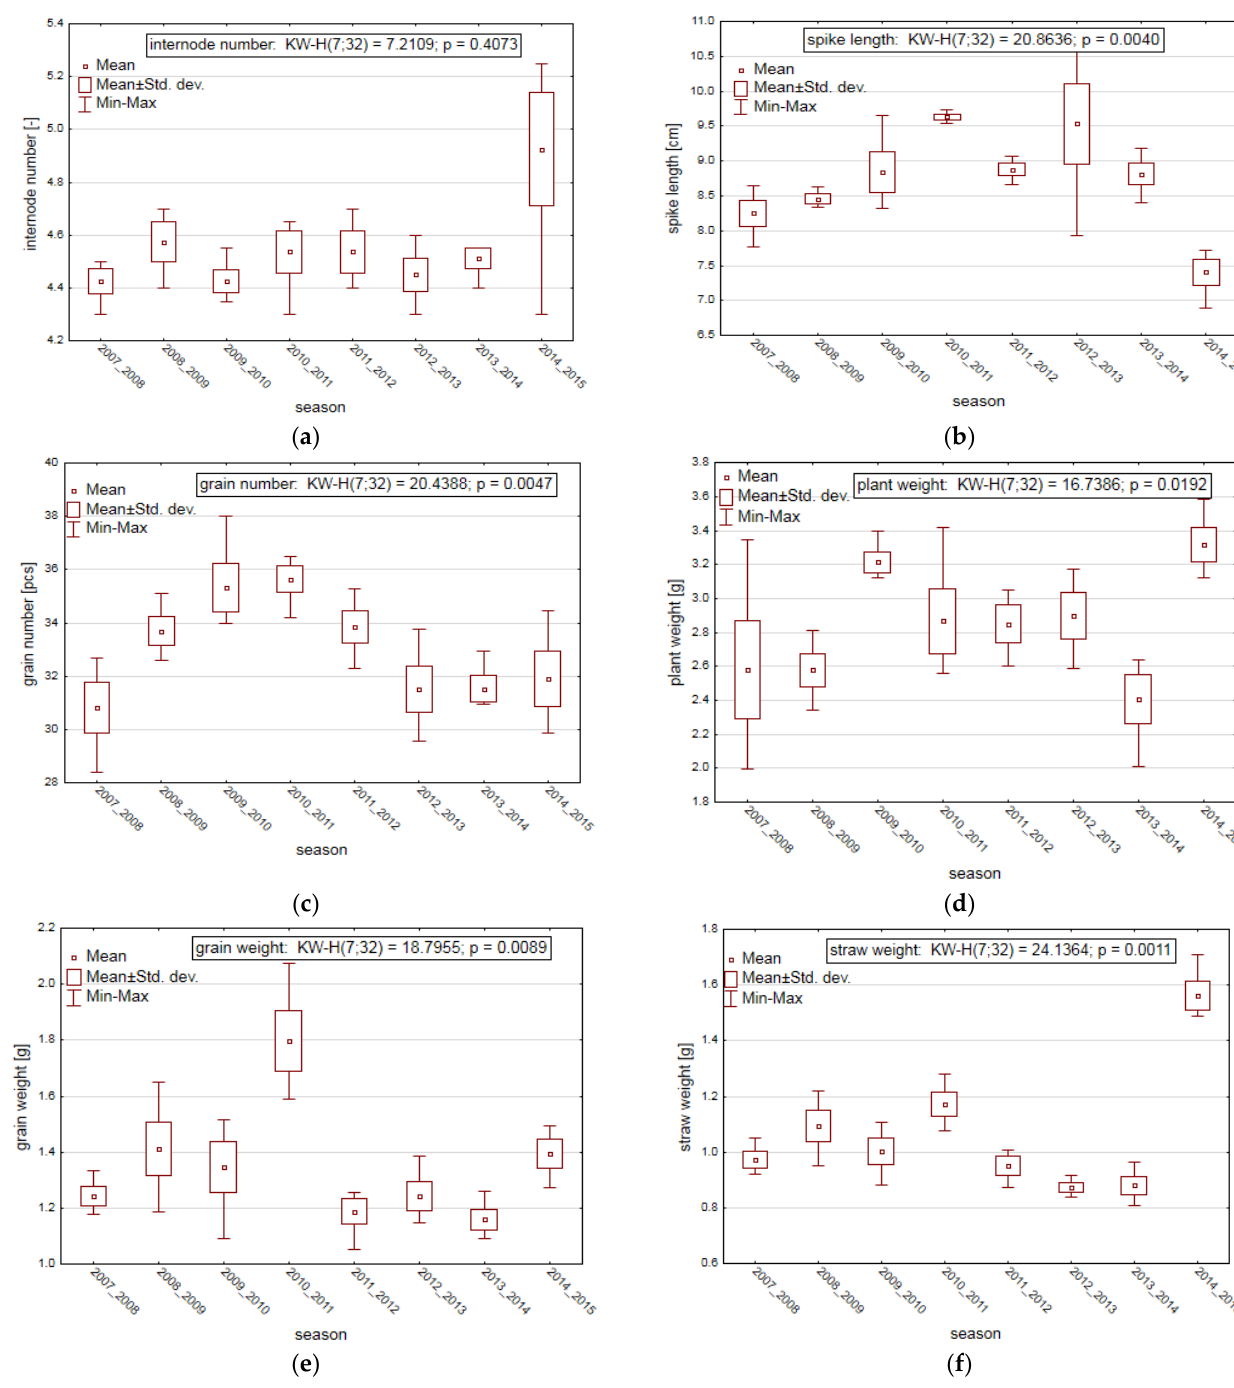
Figure 4. Statistical characterisation of biometric parameters of winter wheat in 2008 – 2015: ( a ) — internode number, ( b ) — spike length, ( c ) — grain number, ( d ) — plant weight, ( e ) — grain weight, ( f ) — straw weight.